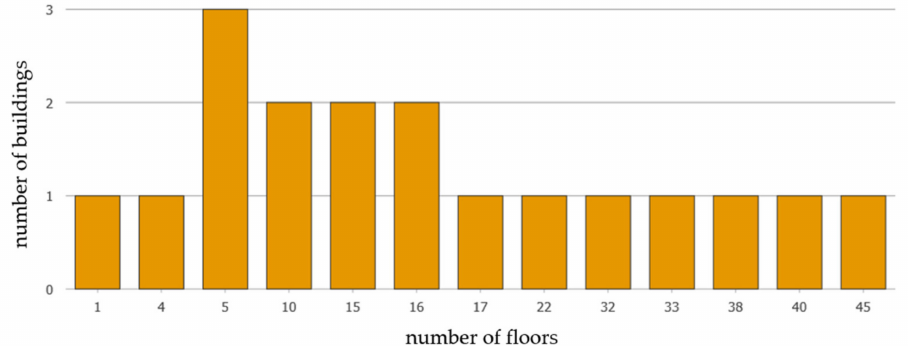
Figure 4. The number of buildings and number of floors of buildings in the vicinity of the Rondo ONZ 04 tram stop, included in the analysis (source: study based on BDOT10k).